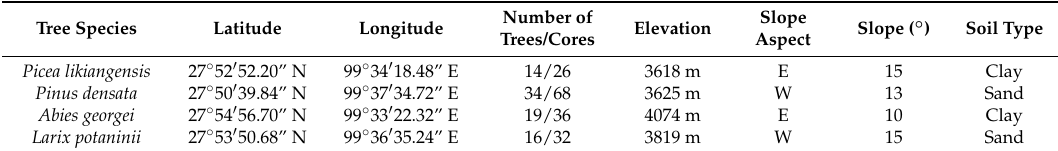
Table 1. Descriptions of the sampling sites.